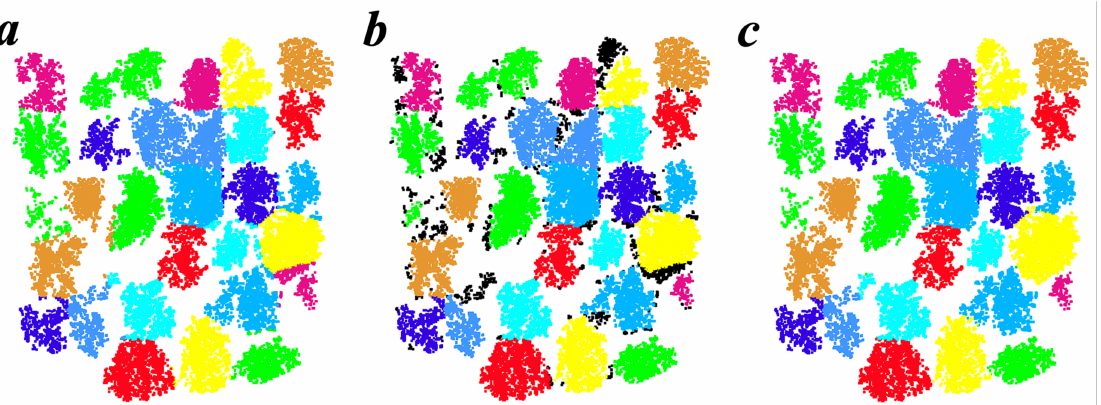
Figure 7. The process of refining segmentation results using plot Y16-2 as an example. ( a ) The initial segmentation results using the Seeds + Silva2016 method; ( b ) core clusters (colored) and other points (black); ( c ) the final segmentation results after improving accuracy using the novel strategy proposed in this study.